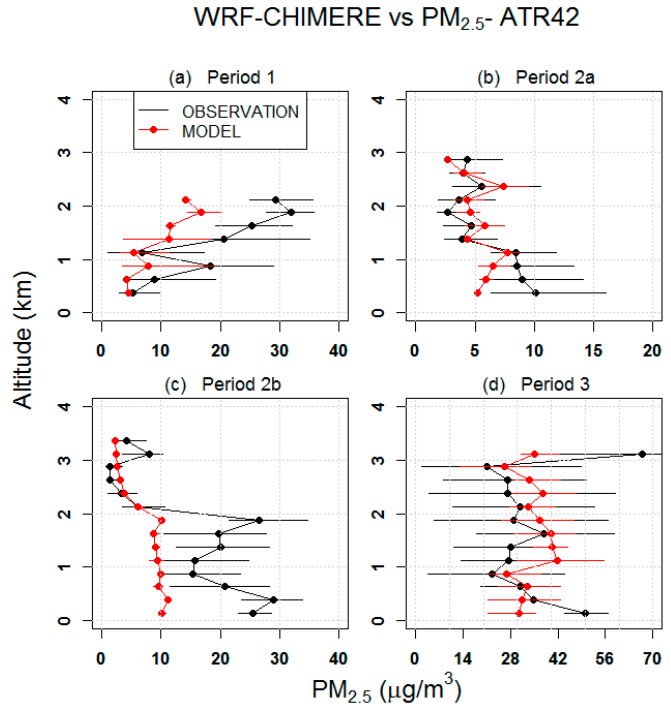
Figure 5. Comparison of measured (black) and modelled (red) vertical profiles along aboard ATR ‐ 42 track of PM 2.5 mass concentration trimean (dots) during the periods ( a ) 1, ( b ) 2a, ( c ) 2b, and ( d ) 3. The black and red bars represent the observed and predicted 25th and 75th percentiles, respectively. Table 5. Trimean (TM) values and interquantile range (IQR) of the aerosol mass concentration of SO 4 , NO 3 , NH 4 , OM, and PM 2.5 measured aboard the ATR ‐ 42 and simulated by WRF ‐ CHIMERE. The values are calculated over the whole periods analysed in boundary layer (PBL) and free troposphere (FT). The units are in μ g/m 3 .